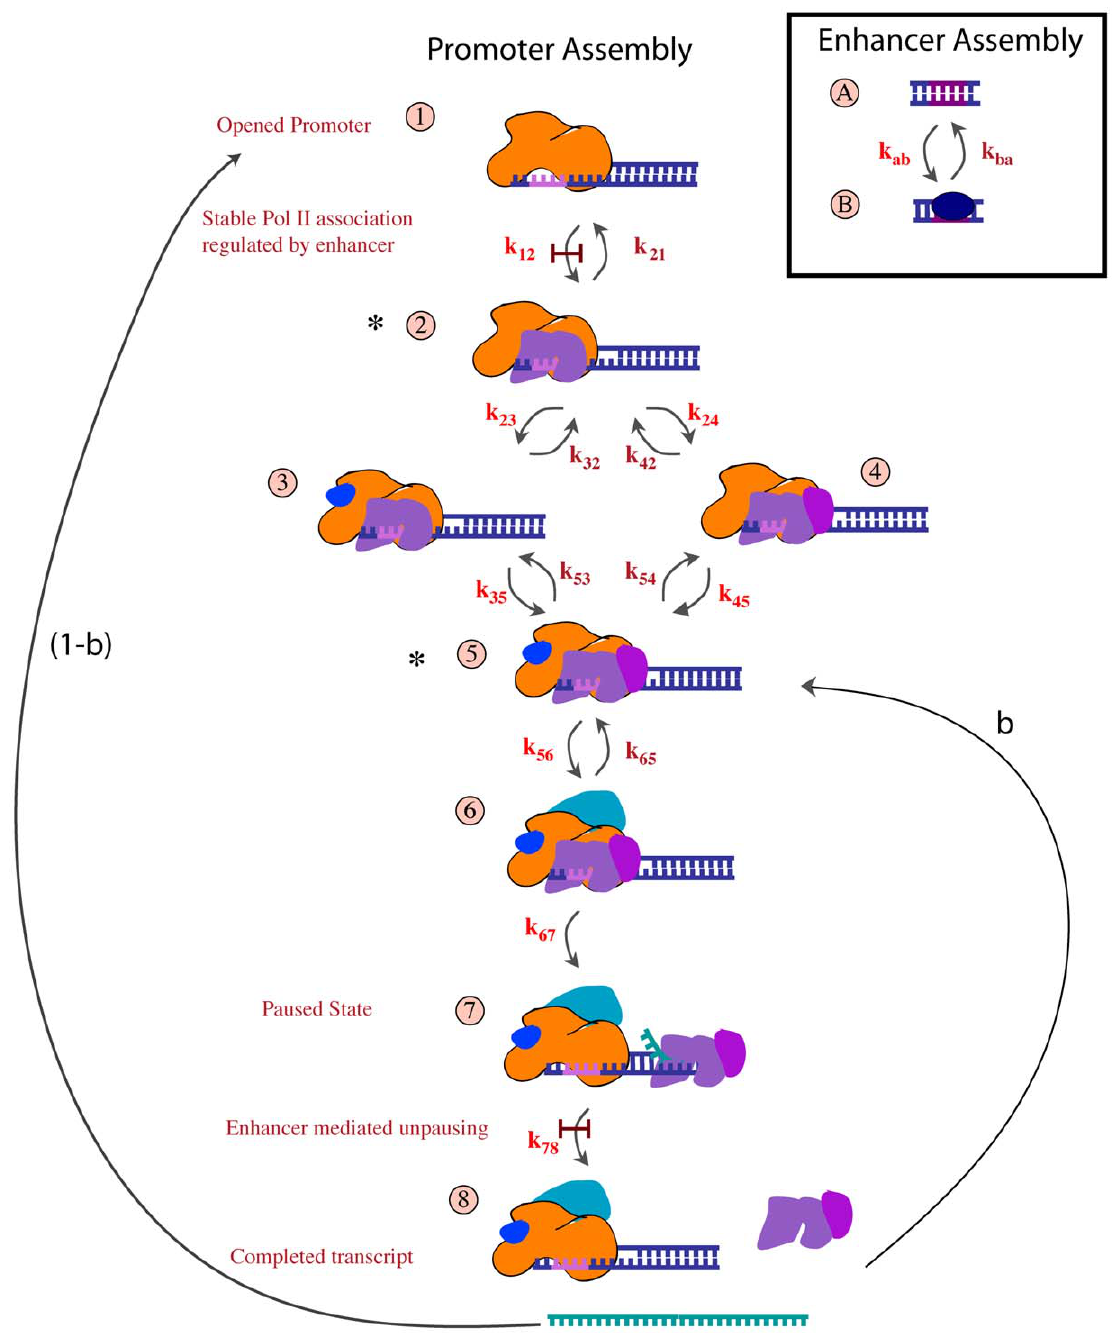
Figure 2. Model of PIC assembly. Each possible complex in the process is enumerated as a state of the promoter Markov chain. (see text for description of each complex) The promoter chain (states 1–8) is combined with the enhancer chain (states A and B) to make the full 16 state model of transcription. Transitions that in some scheme require an activated enhancer (state B) are indicated by a gate, ‘a . Forward rate transitions are in light font and backward transitions in dark font. The 1 ? 2 transition is regulated in the IR scheme, and the 7 ? 8 transition is regulated in the ER scheme. of variation indicates the (relative) magnitude of the stochastic effects.)